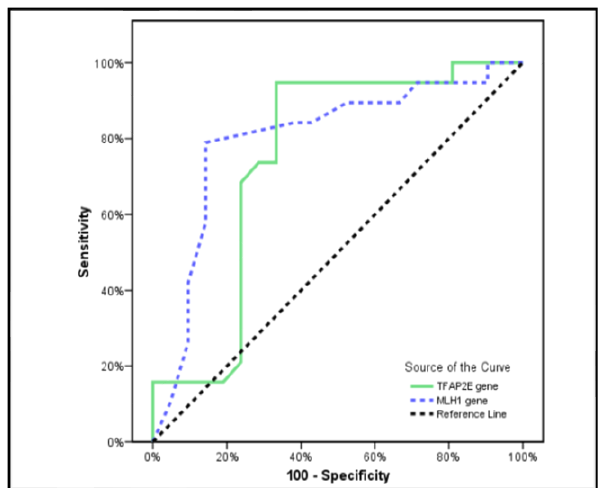
Figure 3: ROC curve analysis of methylation % values for TFAP2E and MLH1